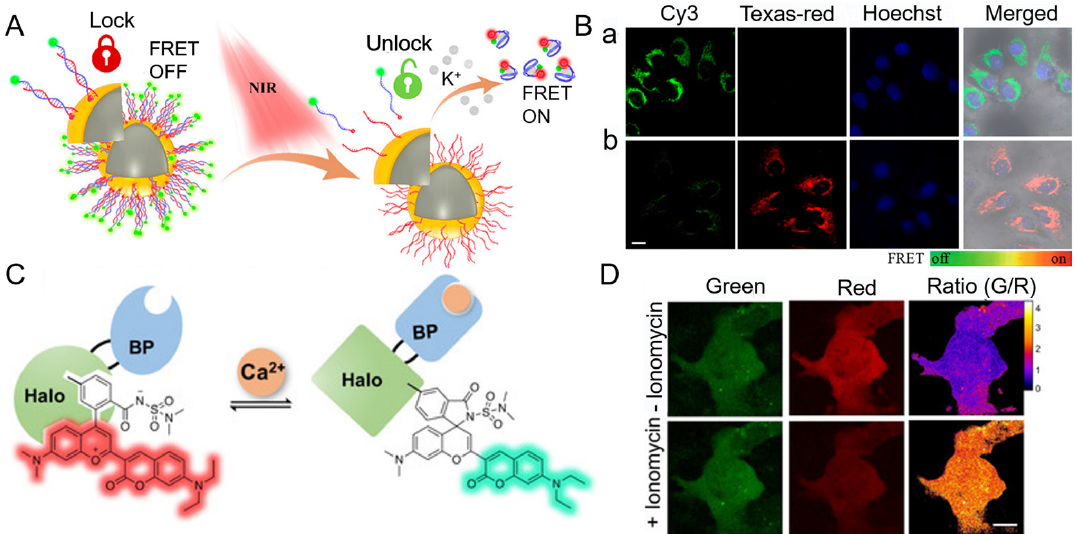
Figure 6. Two representative examples of essential metal ion detection in living cells: ( A ) Schematic illustration of the in situ imaging of K + via the DSAP-AuNS nanosystem. ( B ) Confocal microscopy images of HeLa cells treated with ( a ) DSAP-AuNS and ( b ) DSAP-AuNS + NIR. Reproduced from [101] with permission from the American Chemical Society, copyright 2020. ( C ) Cartoon of the CSF-based semisynthetic Ca 2+ biosensor. Ca 2+ binding induces a conformational change, thereby shifting the equilibrium between red and green fluorescent forms. ( D ) Live cell Ca 2+ imaging with rHCaMP-8. U2OS cells expressing rHCAMP 8 and treated with ionomycin (1 µ M) prior to imaging. Reproduced from [107] with permission from John Wiley and Sons, copyright 2020.